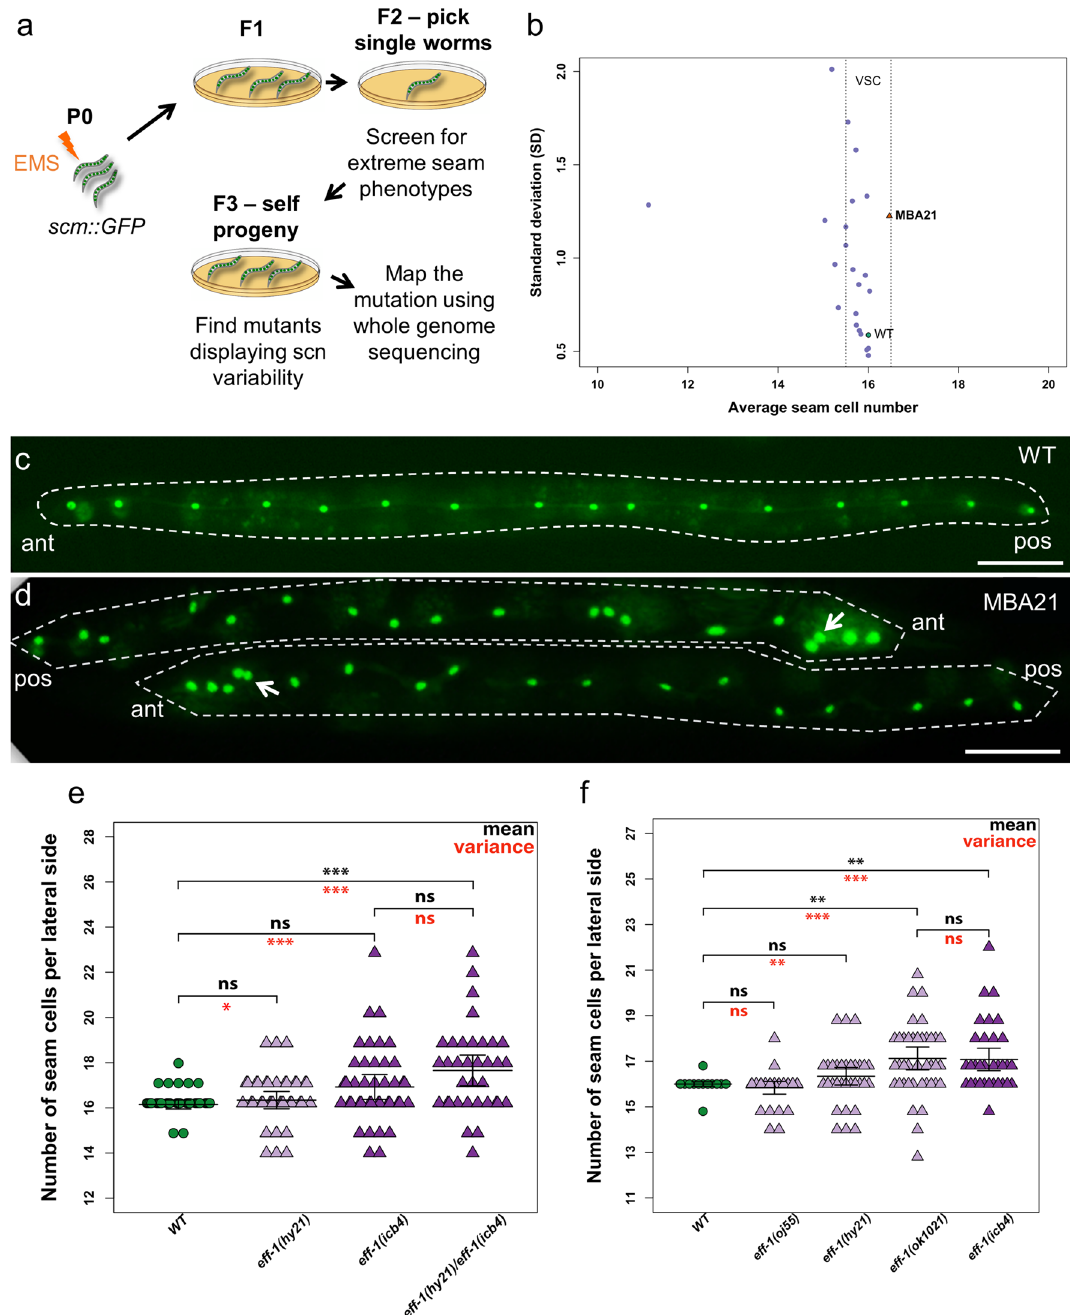
Figure 1. The icb4 mutation represents a strong loss of function allele of eff-1 and leads to seam cell number variability. ( a ) Design of the genetic screen to recover variable seam cell mutants. ( b ) Relationship between average seam cell number (SCN) and standard deviation (SD). Each point represents a mutant from our EMS screen. Parental wild-type strain (JR667) and mutant strain (MBA21) are shown in green and orange respectively, n ≥ 26 animals per strain. Mutants with similar average SCN but higher SD compared to wild type (indicated by the vertical dotted lines) were considered variable seam cell (VSC) mutants. ( c – d ) Representative images of wild-type ( c ) and MBA21 mutants ( d ) at the L4 stage. Note that MBA21 animals are dumpy compared to the wild-type and show an uneven distribution of seam cells towards the head. White arrows indicate clusters of seam cells within the head region. Scale bars are 50 µm and ant, pos stand for anterior and posterior side of the animal respectively. ( e ) icb4 fails to complement the hy21 mutant allele of eff-1 (Missense P183L), 33 ≤ n ≤ 41. A one-way ANOVA showed that the effect of strain on SCN was significant (F (3, 143) = 7.23, p = 2 × 10 −4 ). ( f ) Seam cell number variability is increased in severe eff-1 loss-of- function mutants, 30 ≤ n ≤ 40. A one-way ANOVA showed that there was a significant effect of strain on seam